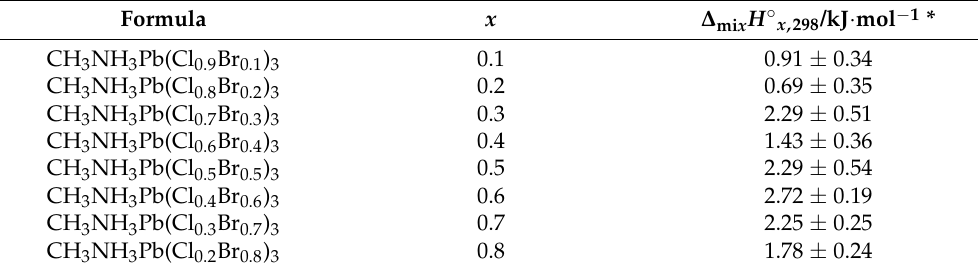
Table 1. The standard mixing enthalpies, Δ mi x H ° x ,298 , in the CH 3 NH 3 PbCl 3 –CH 3 NH 3 PbBr 3 system at T = 298.15 K, p ° = 100 kPa, calculated from the solution enthalpies by Equation (11). Formula